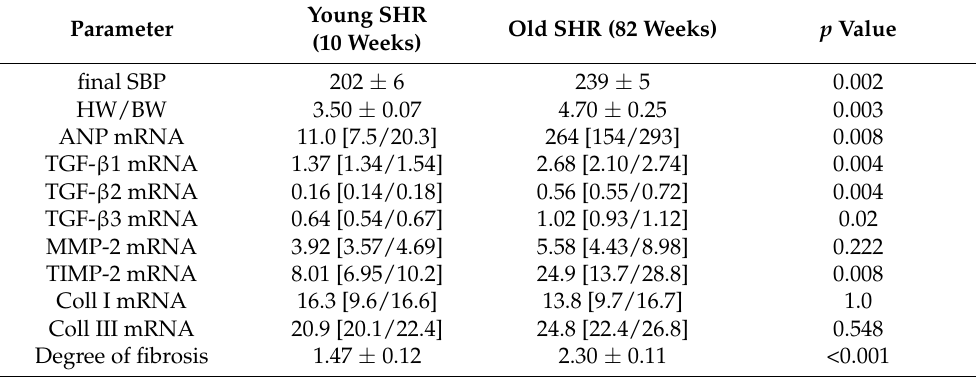
Table 1. Comparison of systolic blood pressure (SBP) and parameters of cardiac hypertrophy and ECM remodeling in young (10-week-old) and old (82-week-old) SHR. Young SHR Parameter Old SHR (82 Weeks) p Value (10 Weeks) final SBP 202 ± 6 239 ± 5 0.002 HW/BW 3.50 ± 0.07 ANP mRNA TGF- β 1 mRNA 1.37 [1.34/1.54] TGF- β 2 mRNA